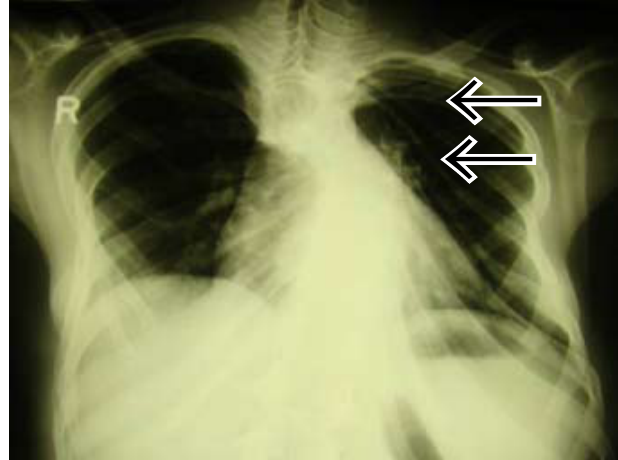
Fig. 10b. Chest X-ray showing twisted ribbon ribs.